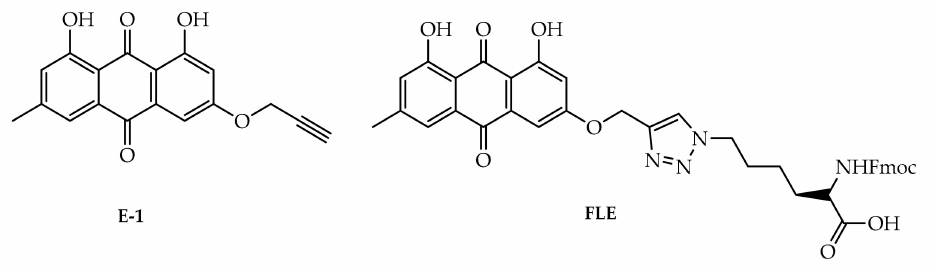
Figure 9. Chemical structures of synthesized emodin derivatives E-1 and FLE.